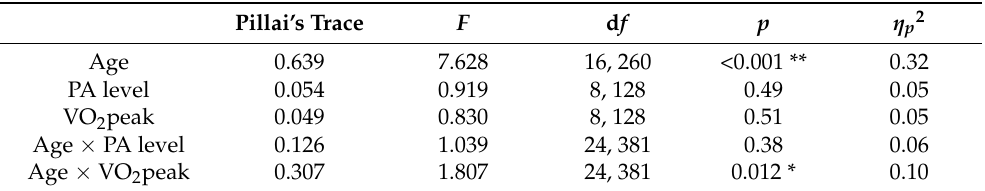
Table 2. MANCOVA results.